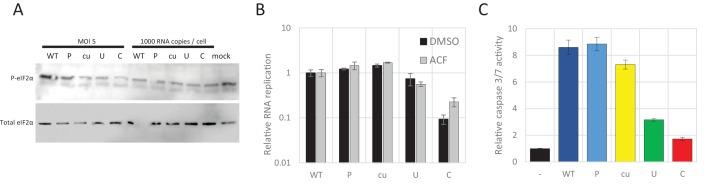
Translation attenuation, RNA interference and apoptosis.(A) RD cells, infected for six hours with equal MOI or equal RNA copies of E7 viruses with indicated R2 variants were immunostained for total eukaryotic initiation factor 2α (eIF2α) or the phosphorylated protein (P- eIF2α). (B) RD cells were pre-treated for two hours with an inhibitor of RNA interference; acriflavine (ACF) or DMSO as a control. Cells were transfected with E7luc replicon RNA containing ncR1 variants in the presence of ACF or DMSO respectively. Bars represent the average luciferase measurements at six hpt relative to WT of three independent experiments and error bars one standard error of the mean. (C) RD cells, infected with E7 viruses with the indicated nucleotide composition of R2 at a MOI of 0.01 were assayed for caspase 3/7 activity at 24 hpi. Bars represent the mean of three independent experiments, normalised for not infected cells. Error bars represent one standard error of the mean.